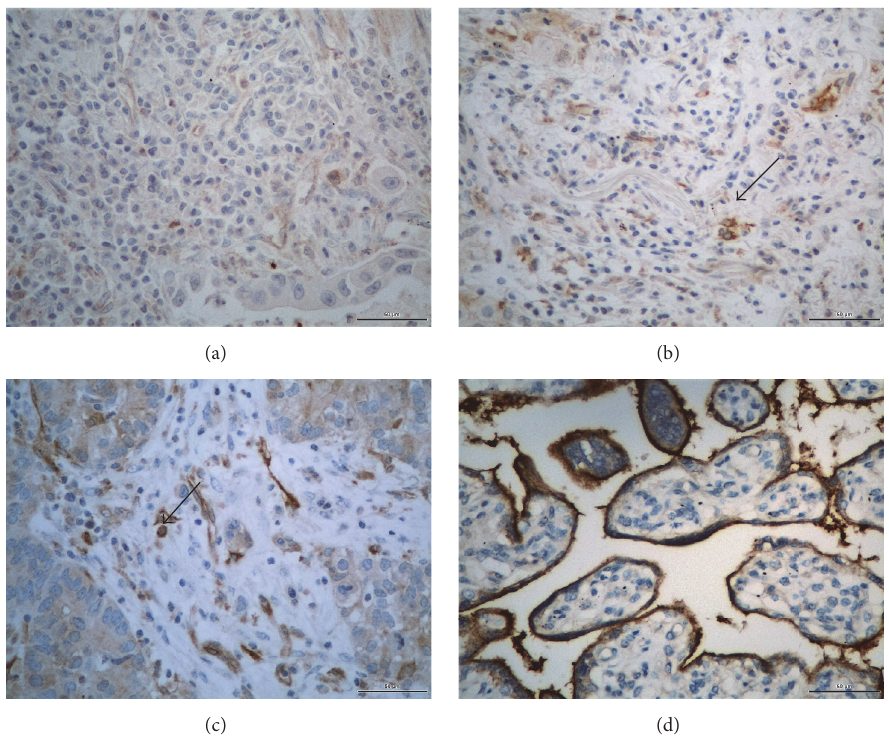
Figure 2: Photomicrographs of PD-L1 immunohistochemical expression in IICs in non-small-cells lung cancer (magnification/scale bar: 400x/50 𝜇 ). (a) Absence of PD-L1 expression; (b) focal PD-L1 expression ( < 5% of tumor surface); (c) diffuse PD-L1 expression ( > 5% of tumor surface). Observe the dendritic cytoplasm of some cells; (d) Positive Control. Arrows show positive staining